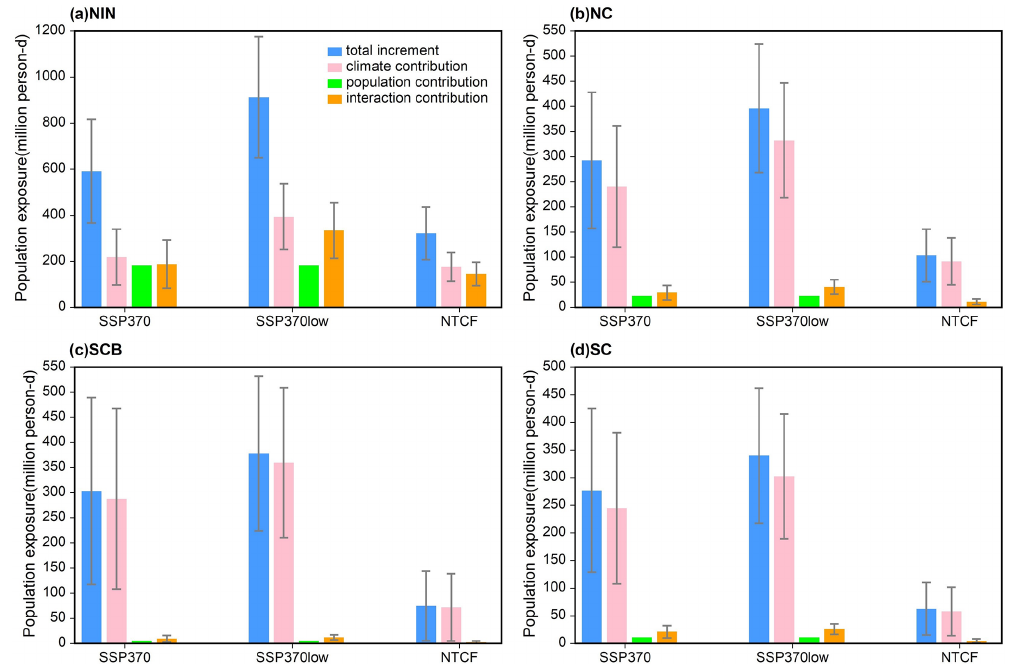
Figure 13. The total changes in population exposure to warm days (TX90p) averaged over northern India (NIN; a ), northern China (NC; b ), the Sichuan Basin (SCB; c ), and southern China (SC; d ) under the SSP3-7.0 and SSP3-7.0-lowNTCF scenarios and its changes driven by the non-methane SLCF reductions. The pink, green, and orange bars represent the changes driven by climate change, population change, and population–climate interaction, respectively. The error bars denote the ± 1 standard deviations across